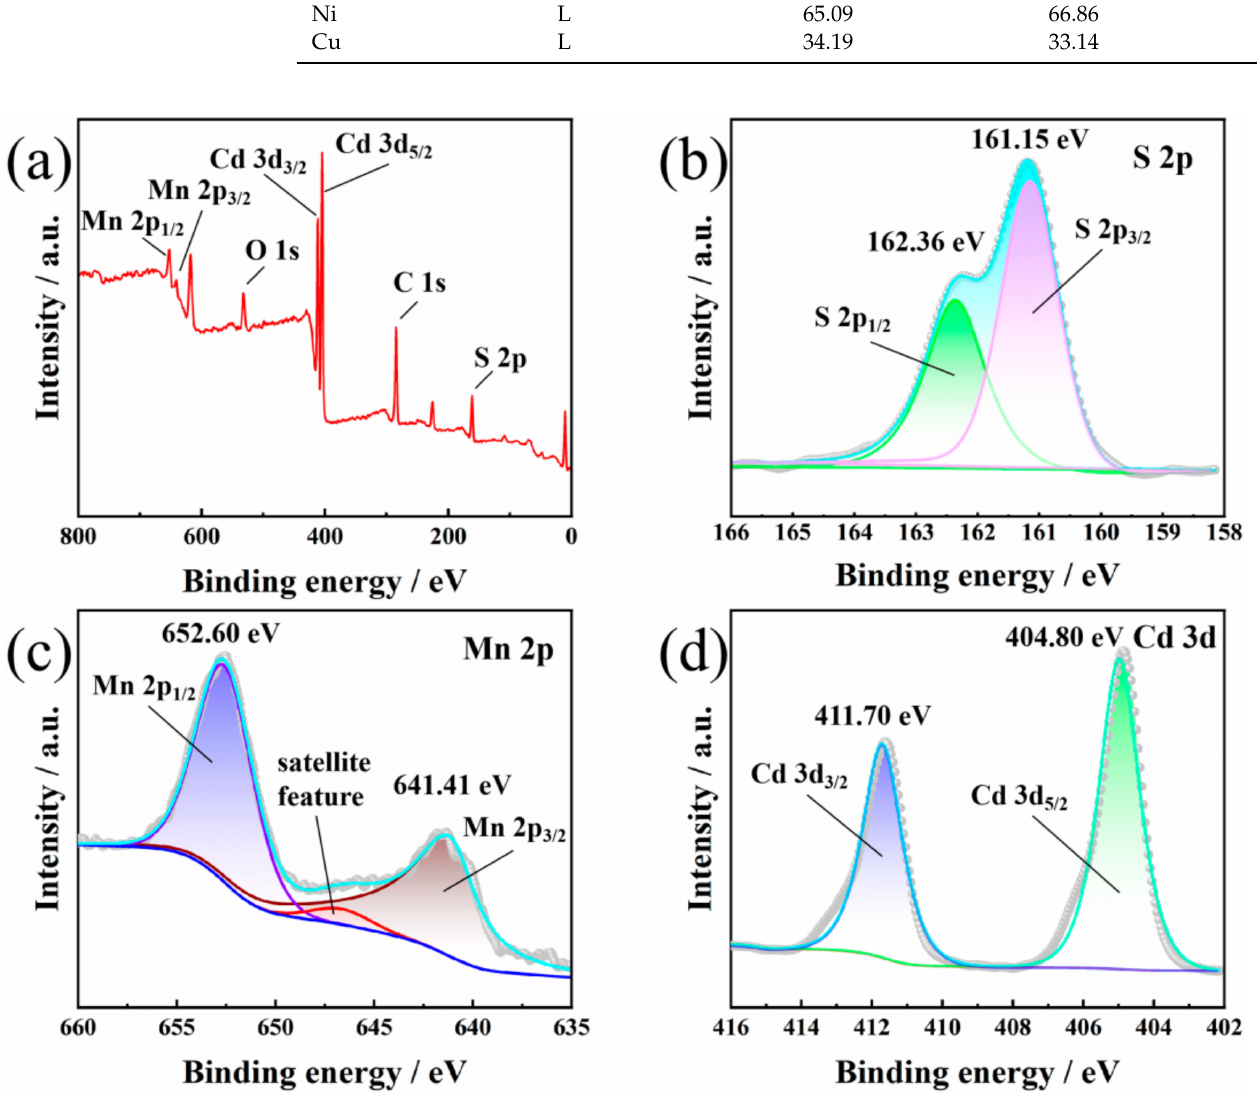
Figure 4. ( a ) XPS survey spectra of MCS-2. ( b – d ) High-resolution XPS spectra of ( b ) S 2p, ( c ) Mn 2p, and ( d ) Cd 3d in MCS-2